Question: In a single sentence, describe what this figure presents.
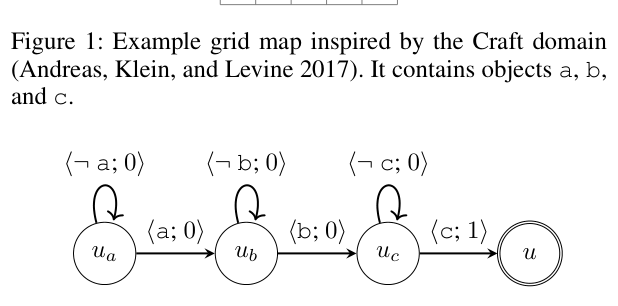
Answer: Boolean reward machine with Boolean features a, b, and c for a sequential task a-b-c.